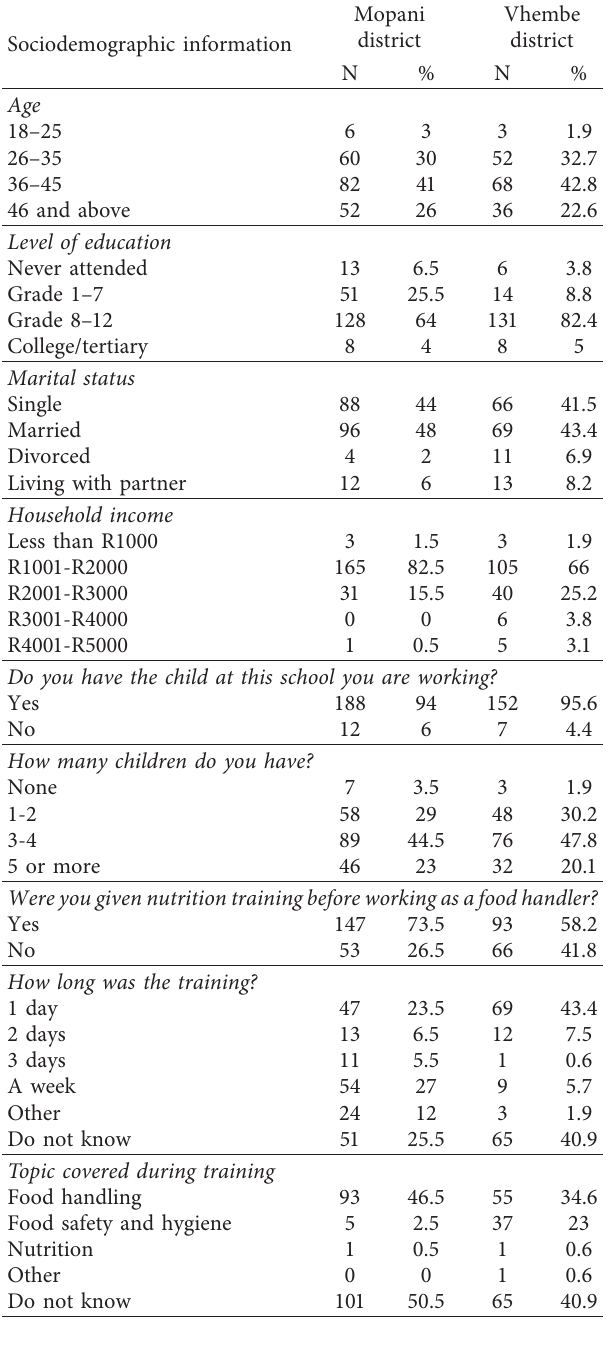
Table 1: Sociodemographic information of participants. Sociodemographic